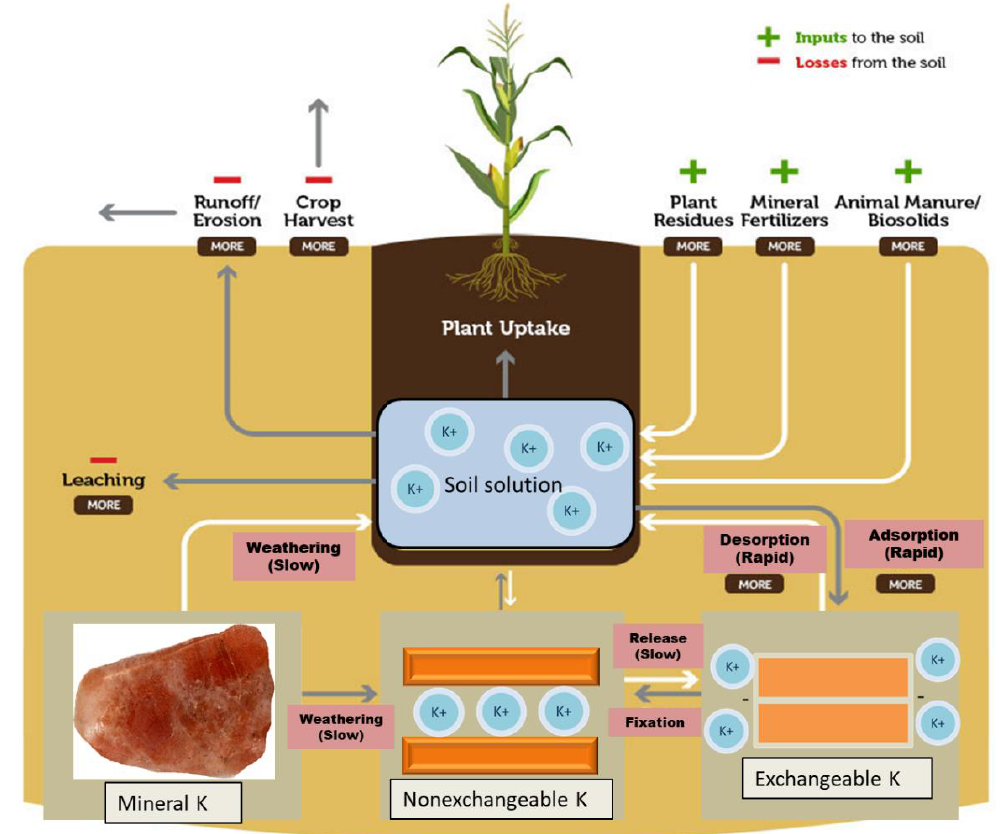
Figure 3. Interrelationships between various fractions of K in soils (adapted from Wang et al. [89]).